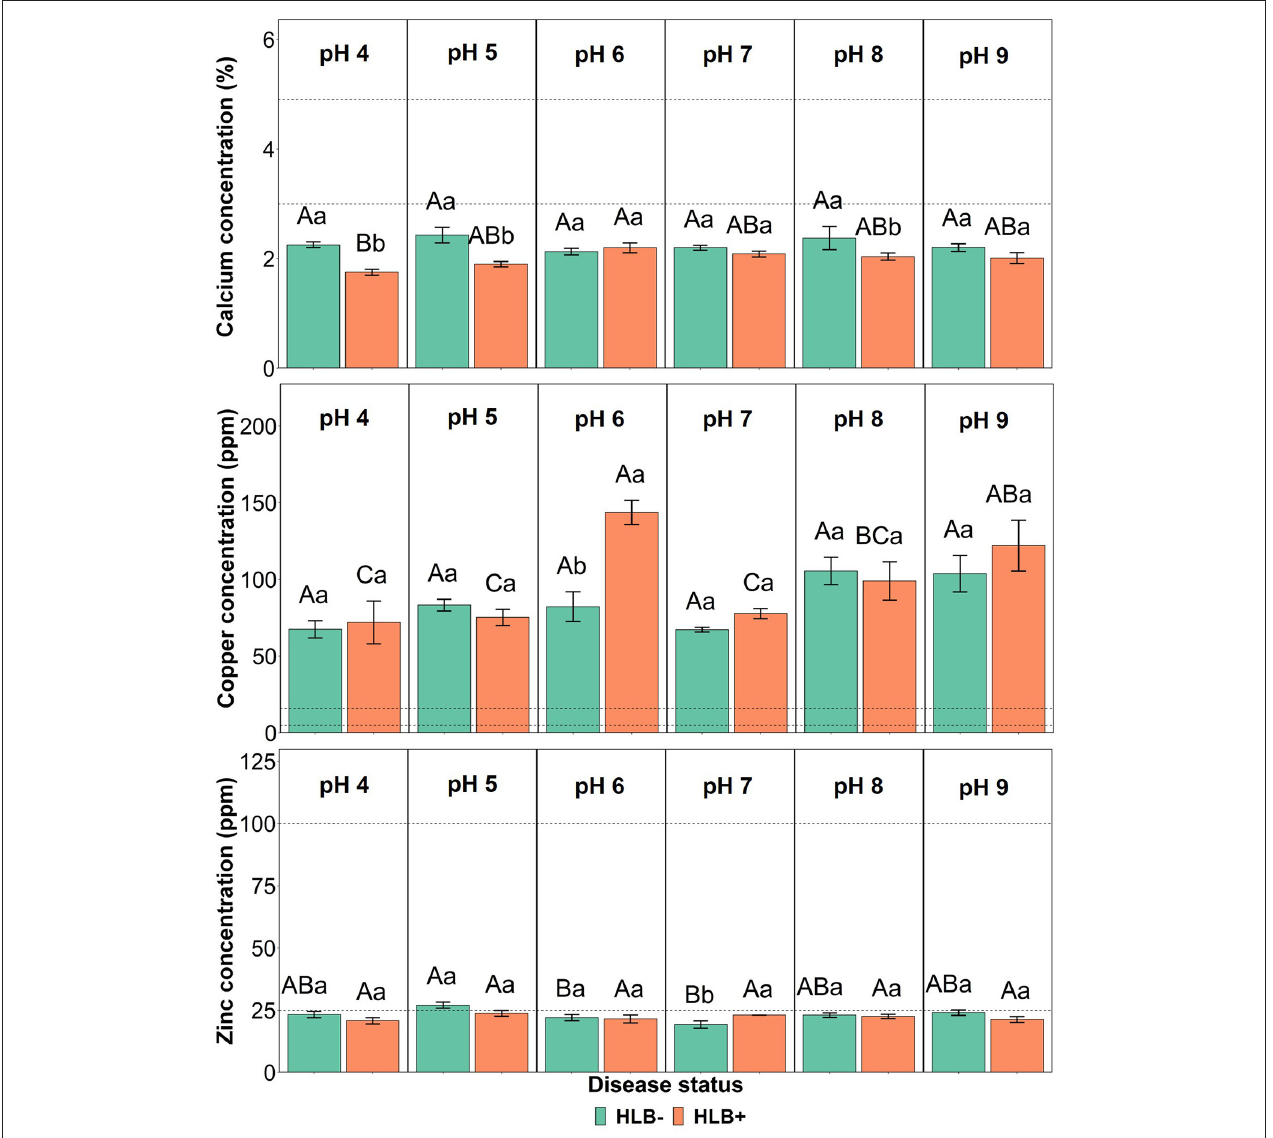
FIGURE 4 | Leaf Ca, Cu, and Zn concentration interactions of “Ray Ruby” grapefruit ( C. paradisi ) on sour orange ( C. aurantium ) rootstock exposed to different HLB disease statuses [HLB-free or healthy (negative, HLB–) and HLB-affected (positive, HLB + )] under an increasing range of substrate pHs (4–9). Means ± standard error ( n = 4) followed by the same letters are not different by Tukey honest significant difference (HSD, α = 0.05). Means with the same uppercase letters are not different on each substrate pH within disease status and means with the same lowercase letters are not different within the disease status per substrate pH. The dashed lines represent the optimum range of the element, according to Morgan et al.